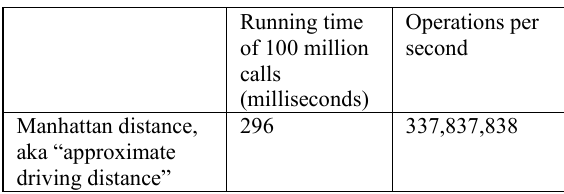
Table 1. Execution speed of Manhattan distance, aka “approximate driving